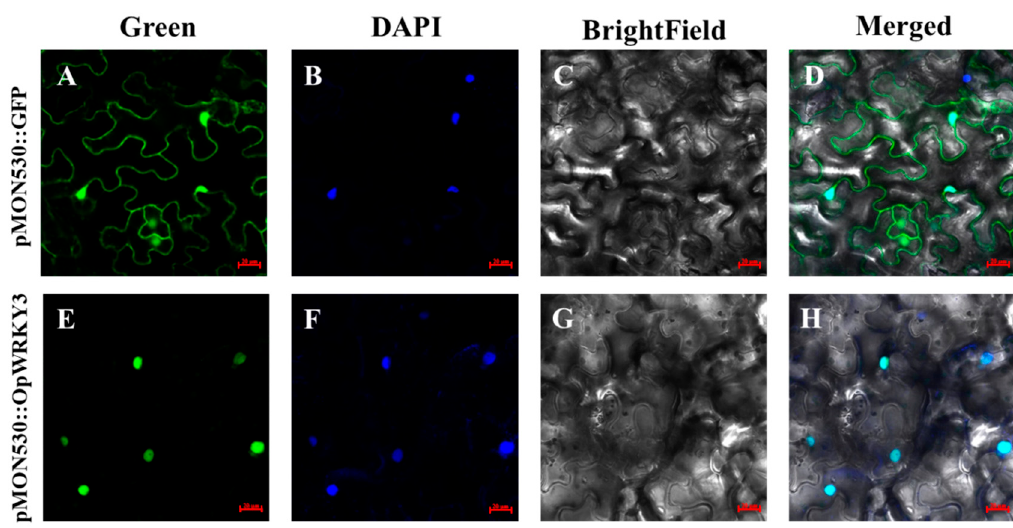
Figure 3. Subcellular localization of OpWRKY3. ( A – D ) The free green fluorescent protein (GFP) expressed in tobacco leaves. ( E – H ) pMON530:OpWRKY3 expressed in tobacco leaves.